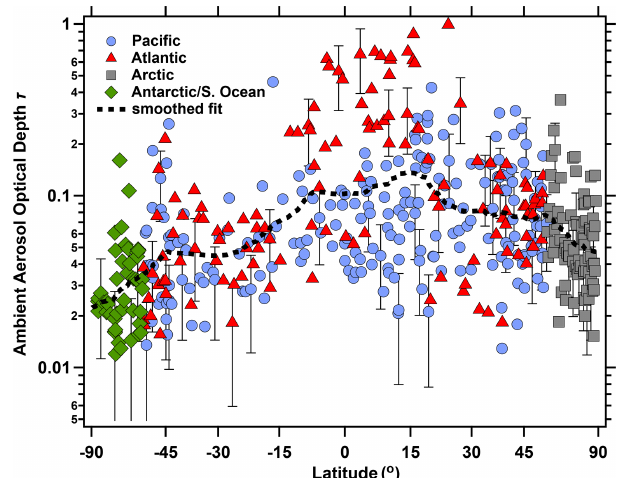
Figure 7. Ambient AOD calculated from in situ measurements as a function of latitude. Symbols indicate data taken over the Atlantic, Pacific, Southern Ocean and Antarctica, and the Arctic, with these regions described in Table S1. The smoothed dashed line is calcu- lated using a locally weighted linear (LOWESS) regression to the logarithm of the AOD